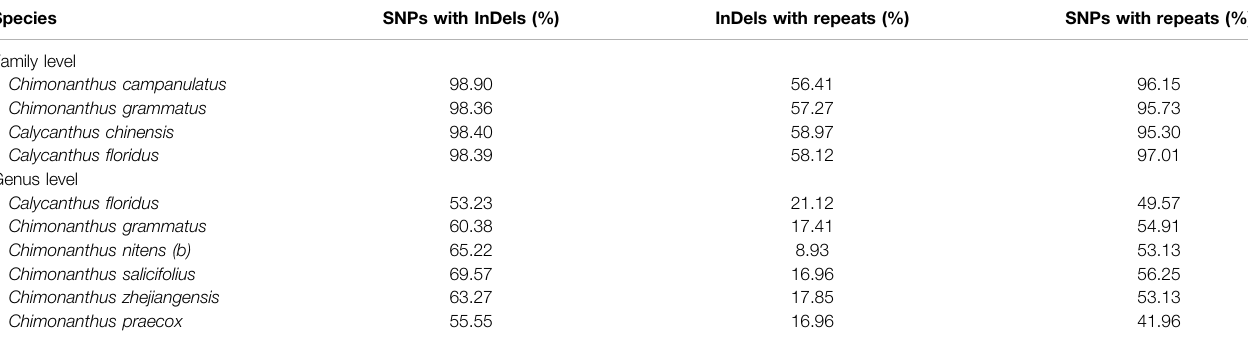
TABLE 3 | The co-occurrence of InDels with substitutions, and of repeats with substitutions and InDels in family Calycanthaceae. Species SNPs with InDels (%) InDels with repeats (%) SNPs with repeats (%) Family level Chimonanthus